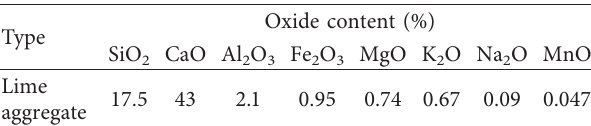
Table 2: Chemical properties of aggregates.